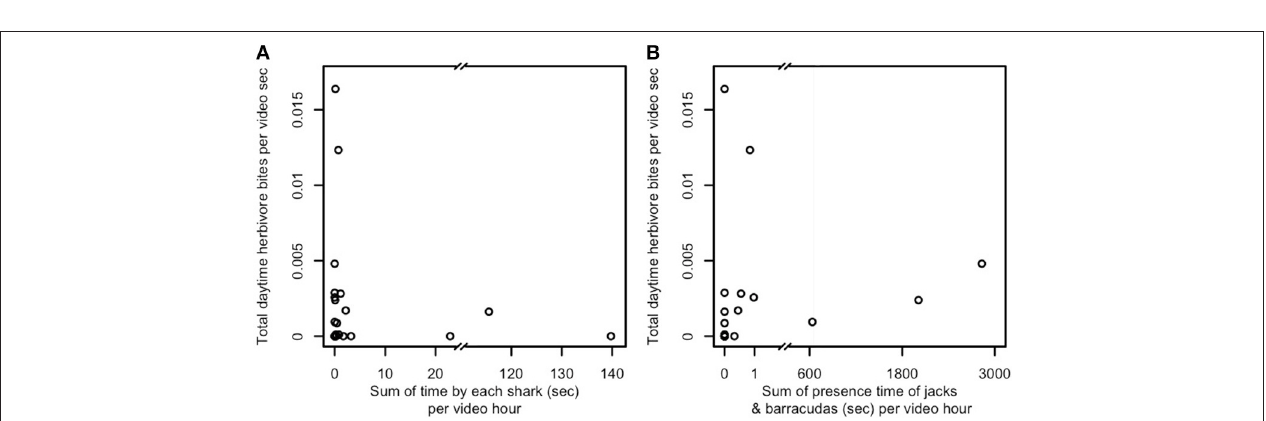
FIGURE 3 | Relationship between predator presence and herbivore bite rate for (A) sharks and (B) jacks and barracudas. Predator presence is measured as total time predators were observed at the study’s 22 focal patch reefs in Heron lagoon (no herbivores were seen on one patch reef; sharks were observed around seven patch reefs and jacks and barracudas around eight). When multiple predators were present, the time each individual was observed was summed to obtain total presence time. Presence time is normalized per hour of video time. Herbivores in this plot include all species observed. Because of the variation of one to three orders of magnitude in predator presence time, because predators were observed at only a minority of patch reefs, and for lack of an a priori model that is sufficiently detailed to explain bite rate observations over such a wide range of predator presence times, we present here the raw data for